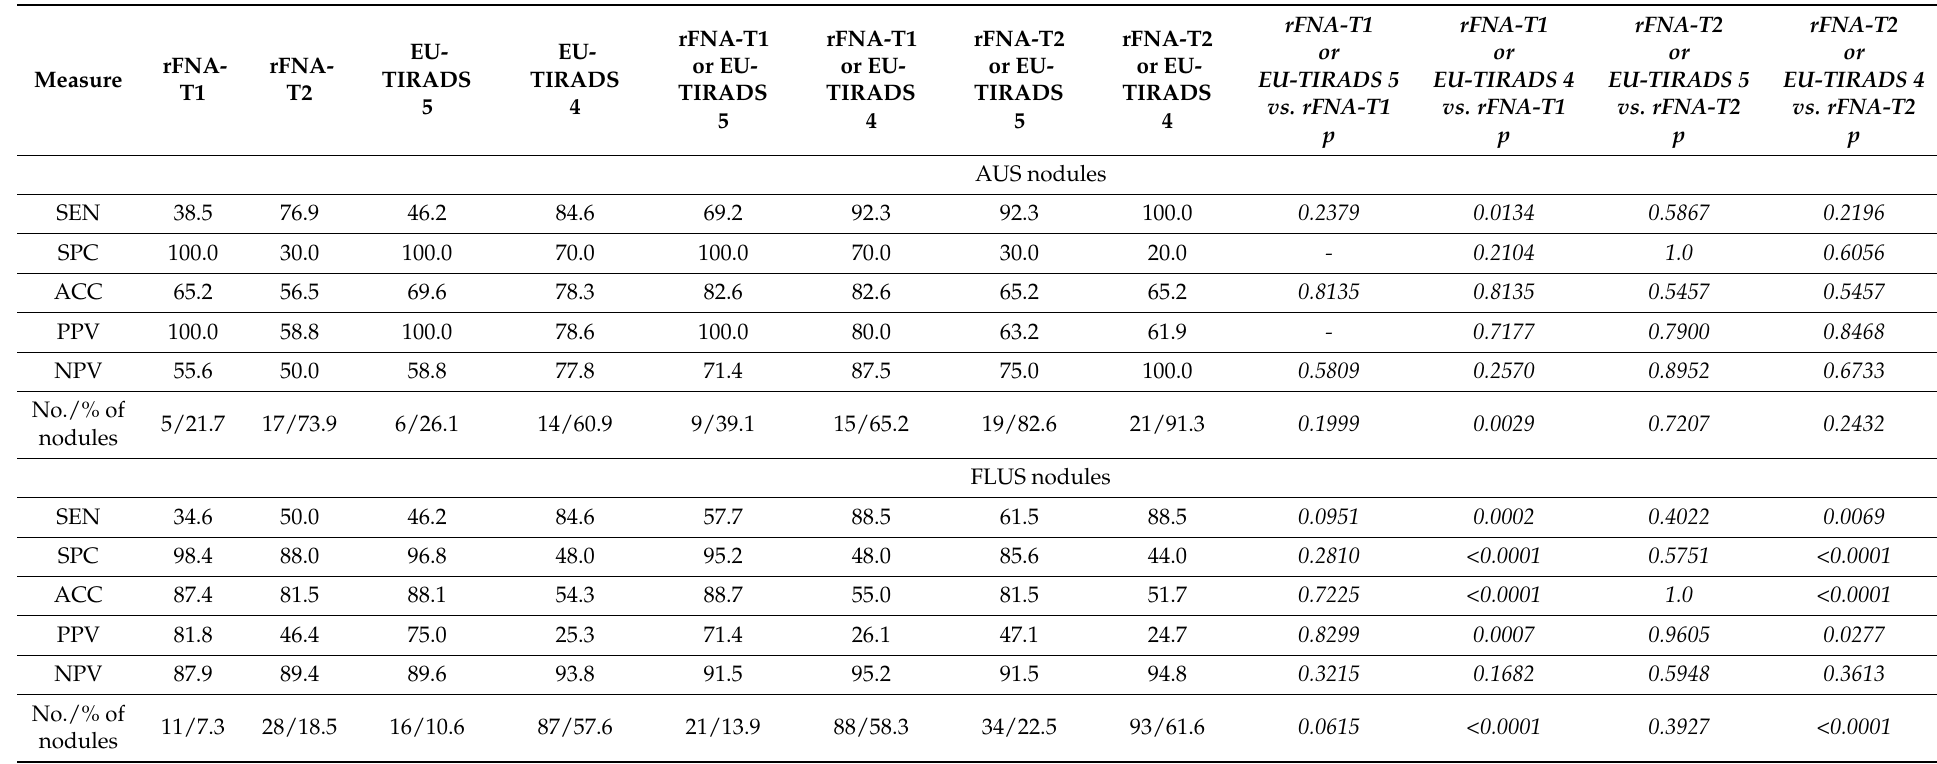
Table 6. Comparison of diagnostic effectiveness of rFNA and EU-TIRADS with their combination for particular cut-off values: rFNA-T1—the cut-off value set at category V of rFNA outcome for both AUS and FLUS nodules, rFNA-T2—the cut-off value set at category III of rFNA outcome for AUS nodules or at subcategory AUS of category III for FLUS nodules, EU-TIRADS 5—the cut-off value set at category 5 EU-TIRADS, EU-TIRADS 4—the cut-off value set at category 4